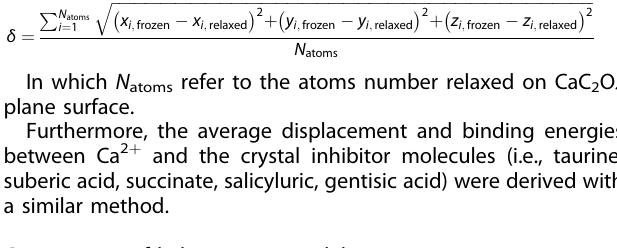
Supplementary Table 6. The thermal cycles program: 95 °C for 30 s; 40 cycles of 95 °C for 10 s and 60 °C for 30 s. The relative level of gene expression by Q-PCR was calculated with a 2 − ΔΔ Ct